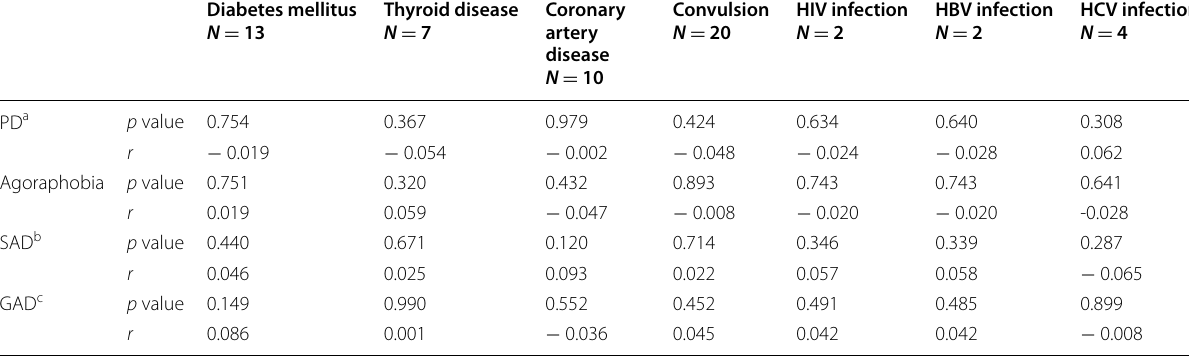
Table 5 Correlations between anxiety disorders and other medical